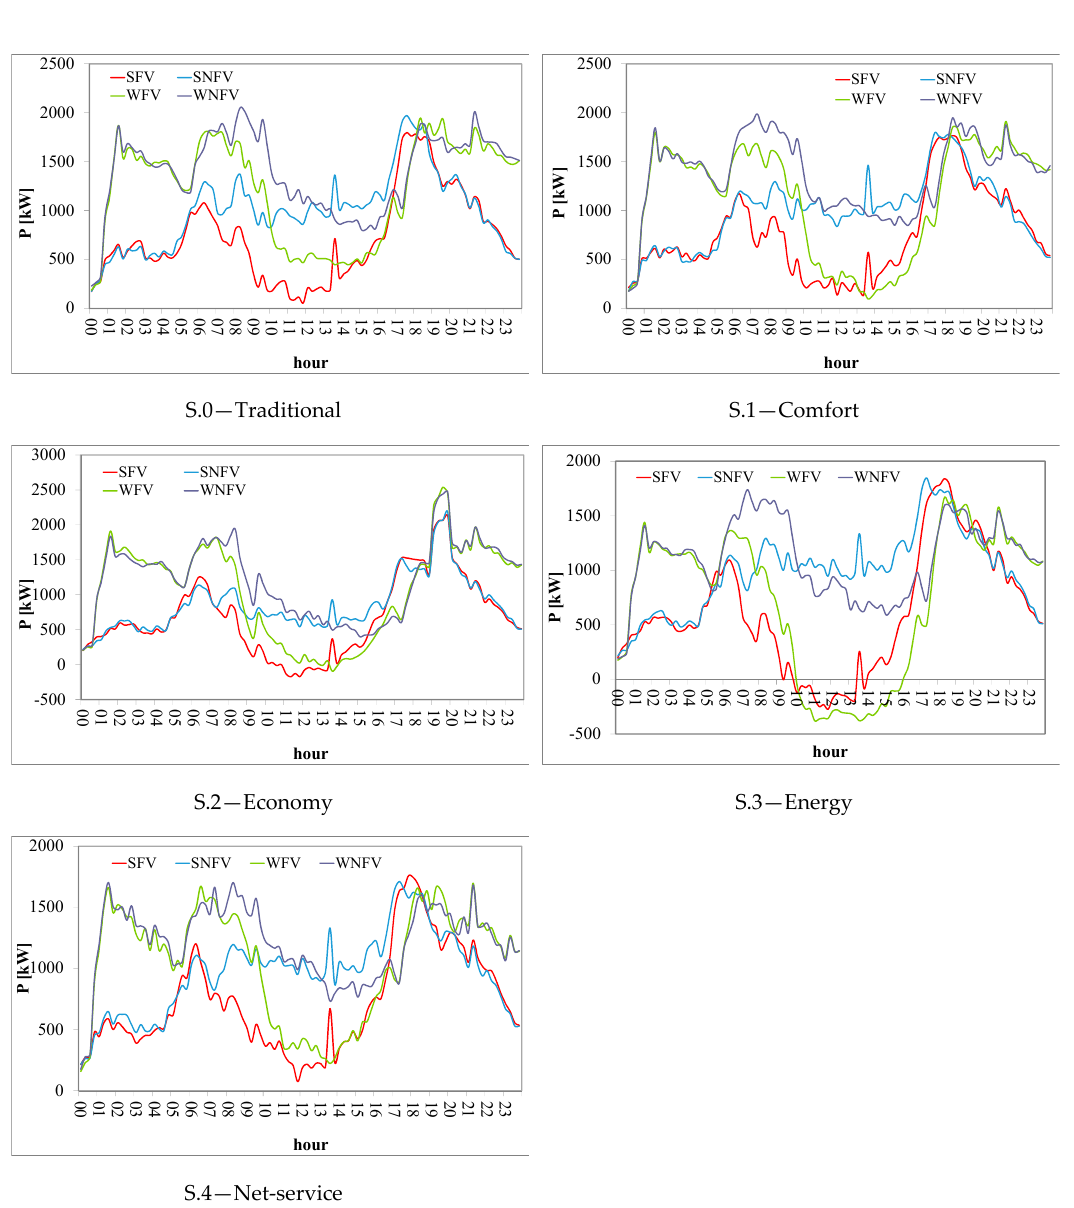
Figure 4. Rome: daily power profile at a primary substation for Scenarios S.0 to S.4.